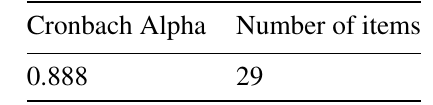
Table 4 Reliability coefficient test.